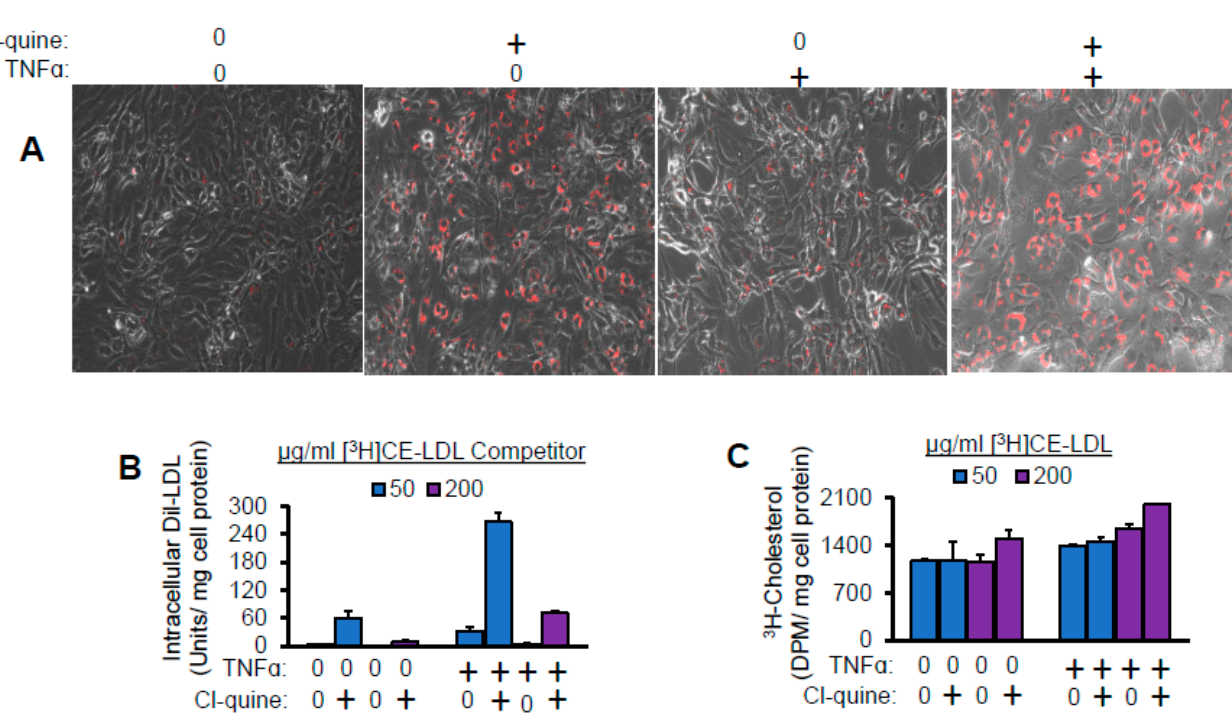
Figure 5. Lysosomal inhibitor enhances TNF α -induced LDL lipid accumulation. The cells were pre-treated with 0 or 100 ng/mL TNF α (+) for 24 h in the presence of serum. Subsequently, in the continued presence of TNF α , the cells were treated with 0.5 µ g/mL Dil-LDL, plus 50 or 200 µ g/mL [ 3 H]CE-LDL, and containing 0 or 50 µ M chloroquine diphosphate (Cl-quine), +, a lysosomal blocker, without serum. After 24 h, the intracellular fluorescence ( A , B ) or radioactivity ( C ) was determined. The separation of #cells in A is an artificact of preparation prior to lysing the cells for radioactivity. The circumferential accumulation of the Dil-LDL in the presence of chloroquine is apparent ( A ). The images are 20X magnifications. n = 2.